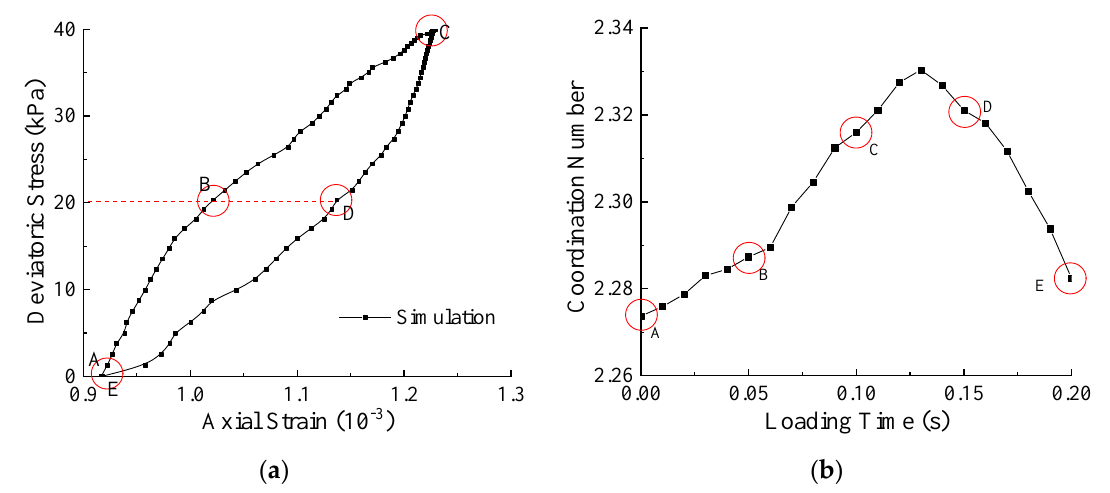
Figure 8. Gradual development with di ff erent loading state: ( a ) stress-strain relationship; ( b ) coordination number.